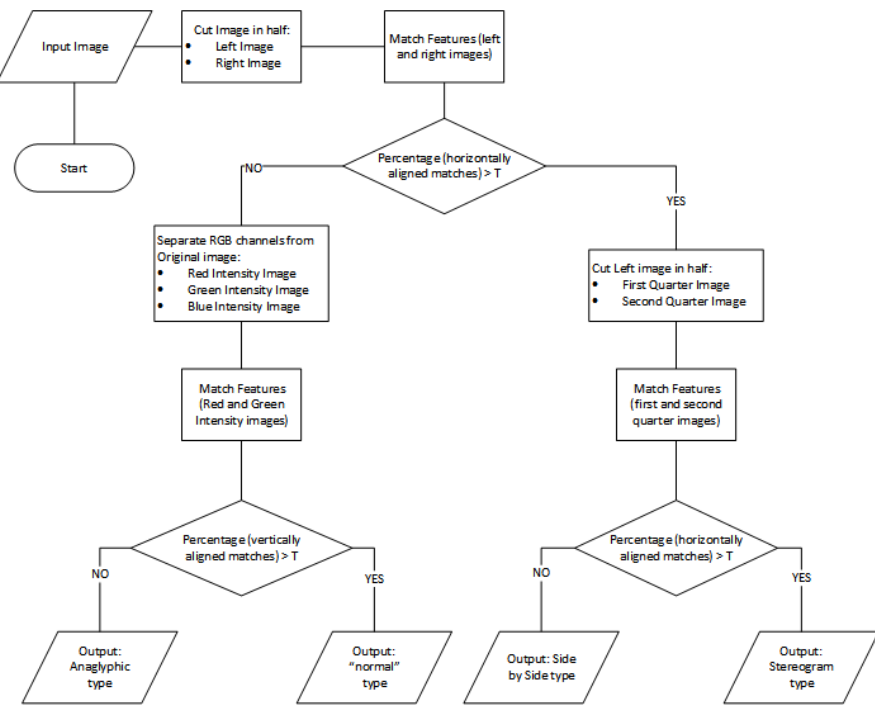
Figure 9. Flow Chart of Our Classification base on KLT matched features.